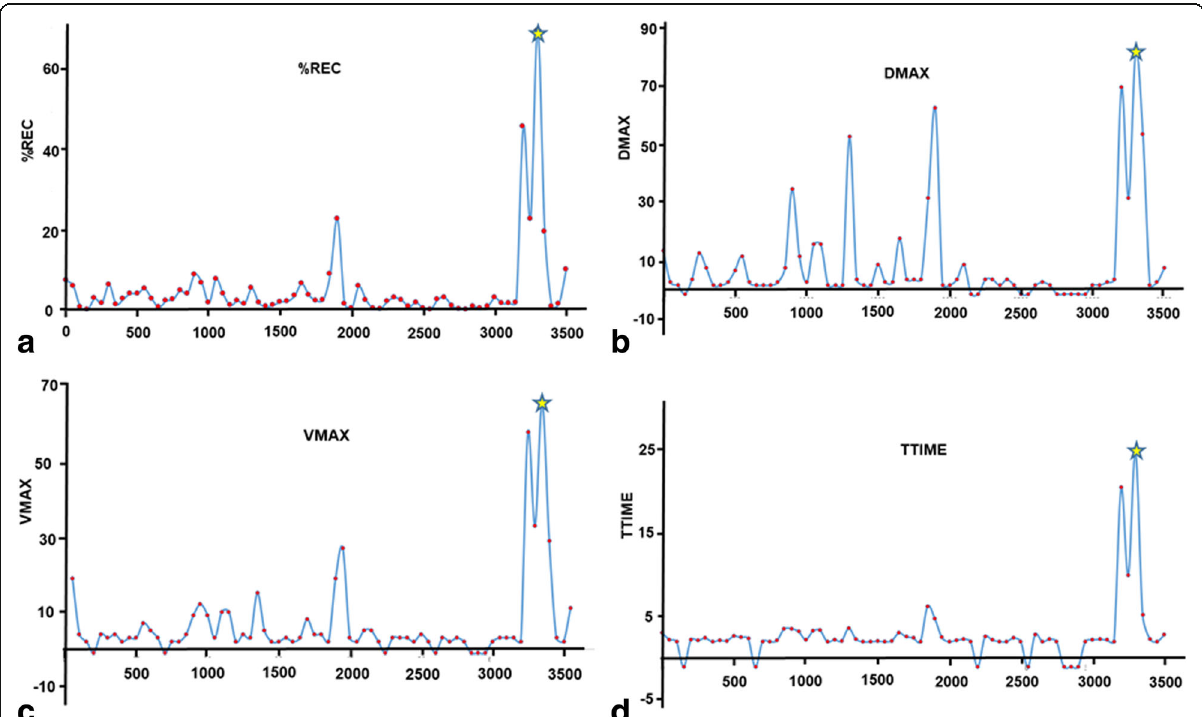
Fig. 22 Joint quantitative measures for CNST_e and KAIK_e. a %REC. b DMAX. c VMAX. d TTIME. Red dots are 50 days apart and mark the beginning of a 100 day sliding window. The yellow star indicates the window (beginning at day 3301) containing the Kaik ō ura event (at day